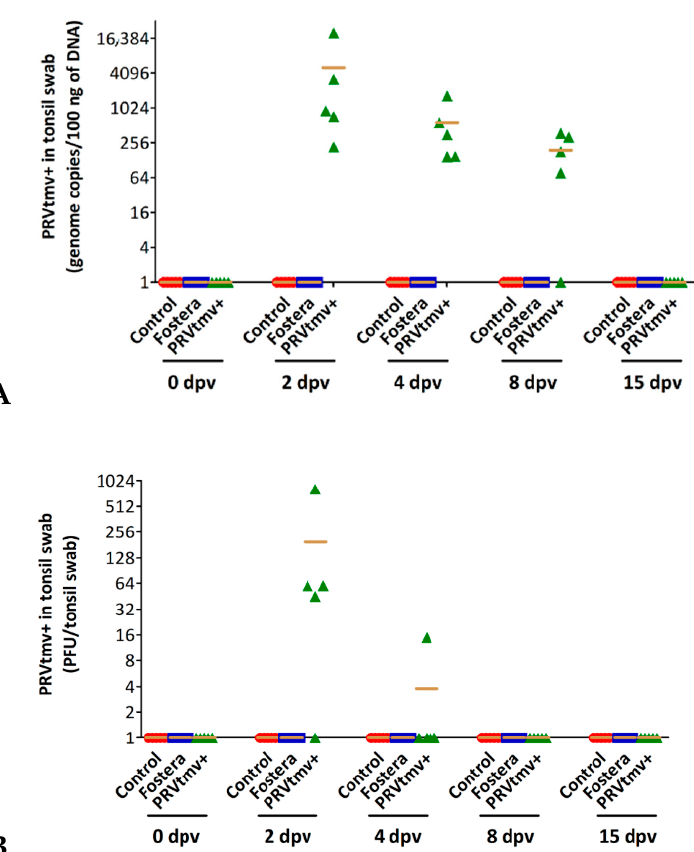
Figure 10. Quantification of PRVtmv+ in tonsil swab of immunized pigs assessed by qPCR and virus isolation. ( A ) DNA was isolated from tonsil swabs following immunization with PRVtmv+ vaccine, and PRV-qPCR was performed. PRV genome copy numbers were calculated according to the CT values of a standard curve. The mean copy numbers of PRV genome in 100 ng of DNA from tonsil swab of two independent qPCR analyses of each animal from three vaccination groups on 0, 2, 4, 8, and 15 dpv are shown. The dot plot graph represents mean + individual values in each group ( n = 5). ( B ) Virus isolated from each animal’s tonsil swab following the immunization with PRVtmv+ vaccine was titrated in confluent SK cells by plaque assay. Shown are the titers (in plaque-forming unit/mL of the nasal swab; PFU/mL) of each animal from three vaccination groups on 0, 2, 4, 8, and 15 dpv. The dot plot graph represents mean + individual values in each group ( n = 5).